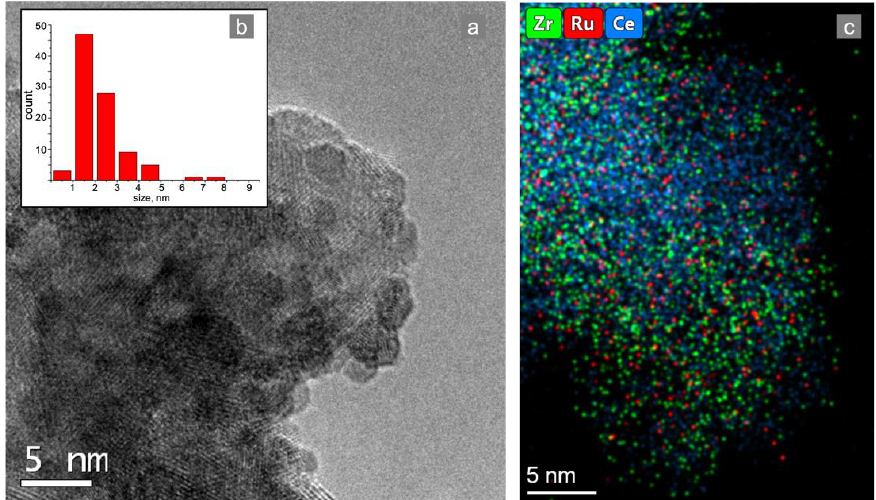
Figure 4. TEM images: ( a ) element distribution mapping of the ( c ) Ru/CZA/FeCrAl catalytic coating and ( b ) Ru particle size distribution.